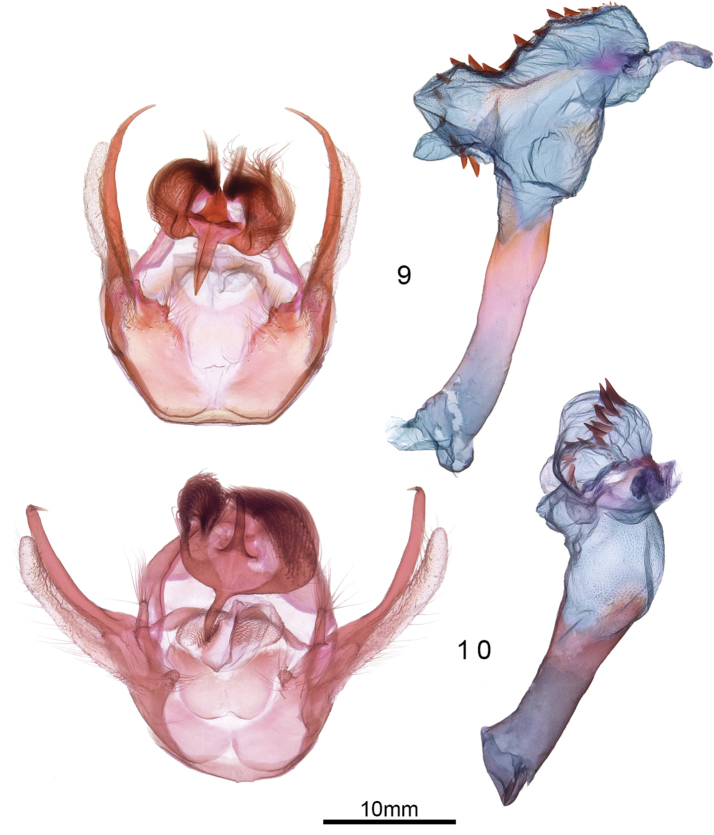
Male genitalia of 9Euchaetesnancyae and 10E.helena.